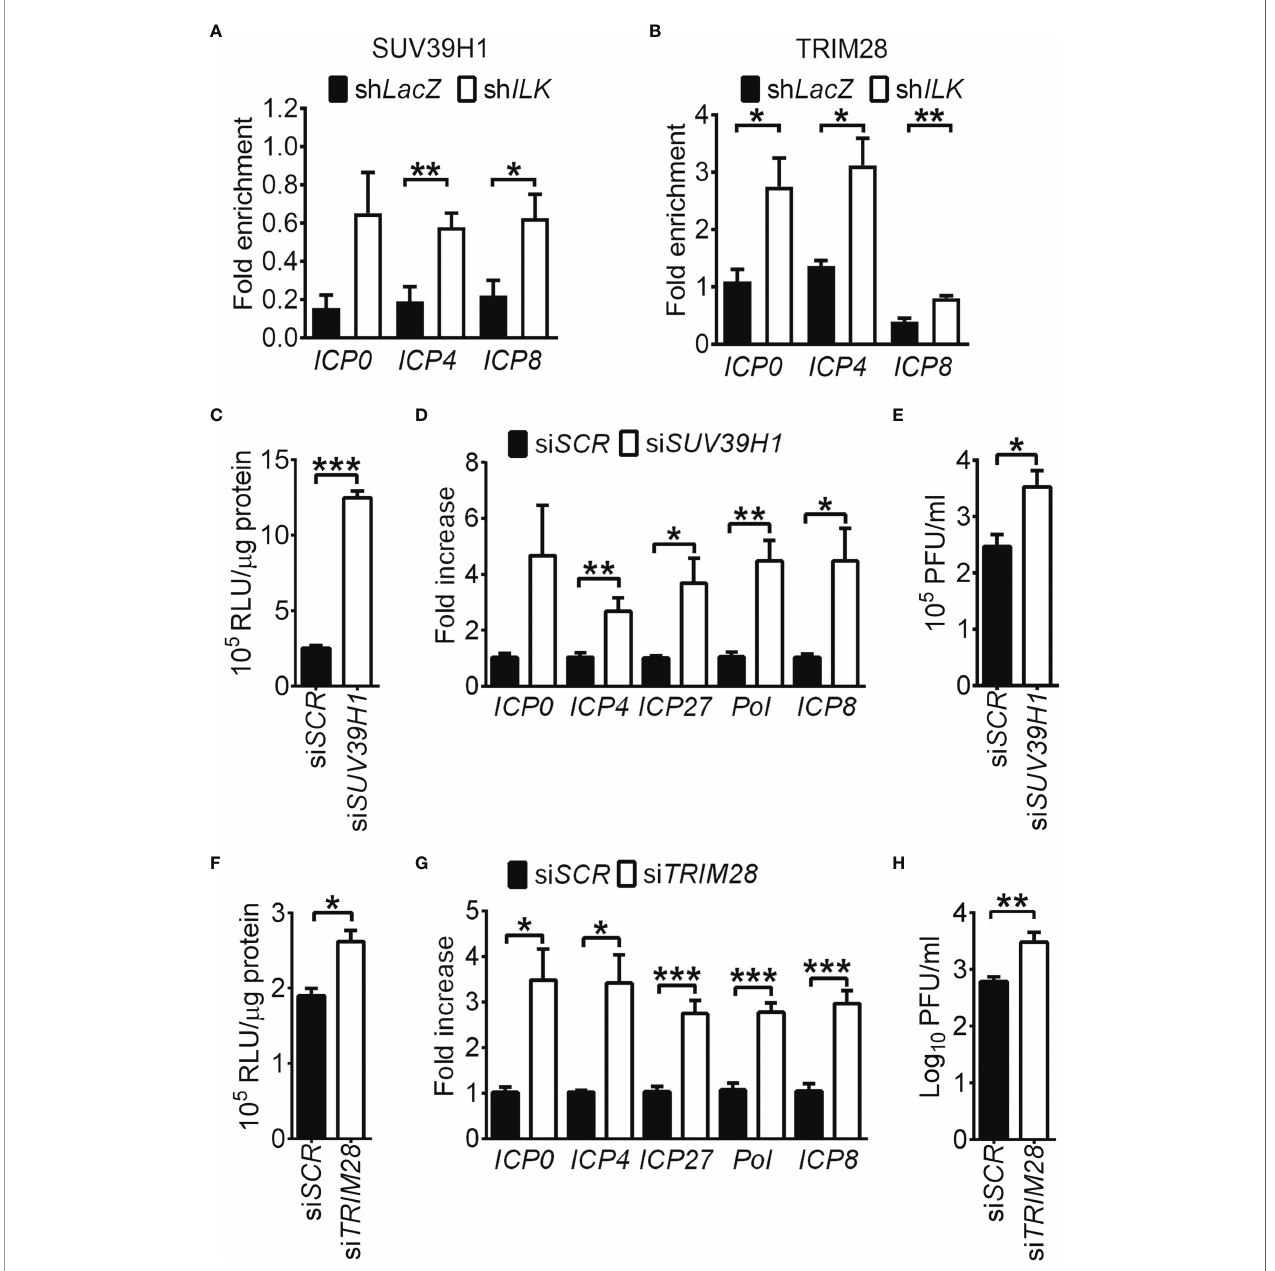
FIGURE 5 | ILK antagonizes the TRIM28-SUV39H1-repressed viral gene transcription. (A, B) The relative levels of SUV39H1 (A) and TRIM28 (B) associated with ICP0 , ICP4 , and ICP8 promoters in control (sh LacZ ) and ILK knockdown (sh ILK ) cells infected with HSV-1 at 3 hours postinfection are shown. Fold enrichment was calculated as the fraction of DNA immunoprecipitated by the speci fi c antibody/input normalized to the control antibody/input. (C, F) The luciferase activities in uninfected ILK knockdown cells transfected with scrambled siRNA (si SCR ) or siRNA targeting SUV39H1 (si SUV39H1 ) or TRIM28 (si TRIM28 ) and pGL3 vector carrying ICP4 promoter are shown. (D, G) The relative transcript levels of indicated viral genes in ILK knockdown cells transfected with indicated siRNA and infected with HSV-1 for 6 hours are shown. The transcript levels of indicated genes relative to ACTB in ILK knockdown cells with si SCR were set as 1. (E, H) The viral yields in ILK knockdown cells transfected with indicated siRNA and infected with HSV-1 (MOI = 0.01) for 24 hours are shown. Data represent mean + SEM (error bar). * p < 0.05, ** p < 0.01, *** p < 0.001 via Mann-Whitney U test in panel E and H and Student t test in the rest